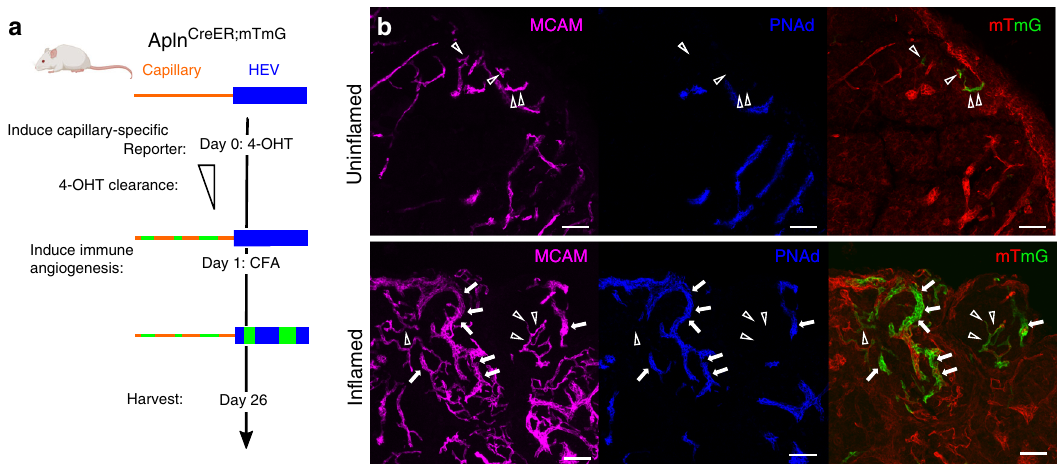
Fig. 6 Lineage tracing of AplnERTCre-expressing capillary EC. a Experimental protocol. b Representative images of Apln -driven reporter expression (GFP) in PLN from Apln-CreER x R26-mTmG mice at rest (upper) and three and half weeks post-immunization with CFA (lower panel). EC subsets were labeled by i.v. injection of the indicated antibodies 10 – 20 min before sacri fi ce: PNAd (blue), MCAM (magenta). Arrow heads, capillaries. Arrows, HEV. Bars, 50 µ